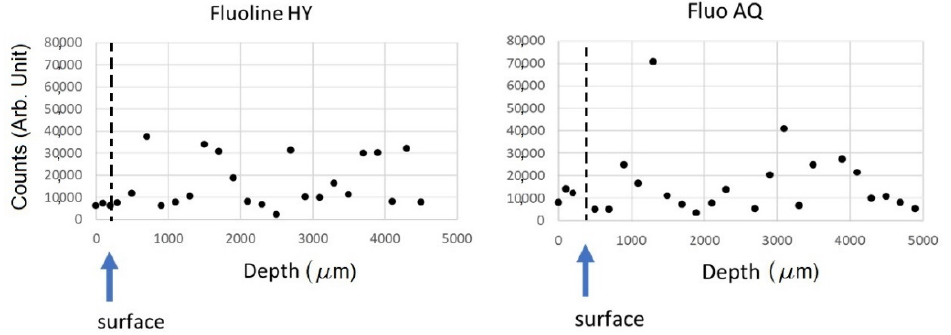
Figure 2. Fluorine peak area counts detected along the deepness profile of the two cross-sections.